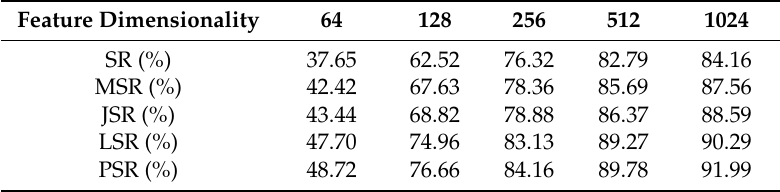
Table 4. The recognition results for configurations of BMP2.